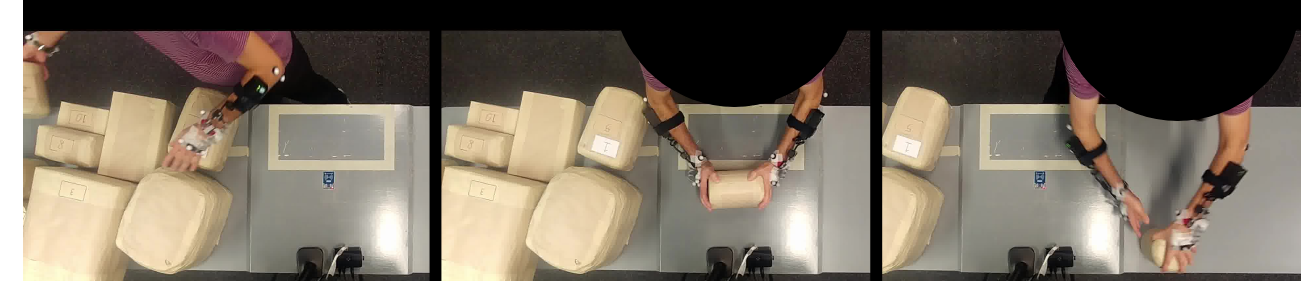
Figure 3. Checkout scanning task showing object selection ( left ), object scanning ( center ), and object placement ( right